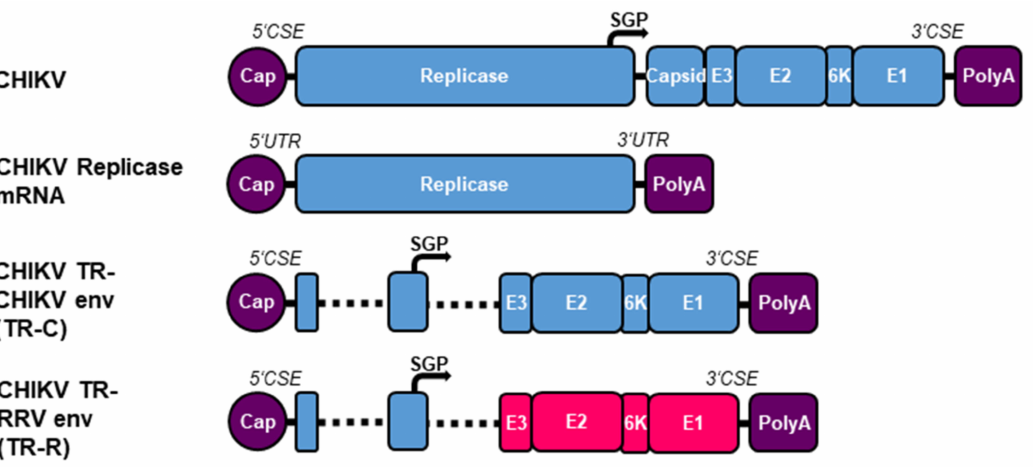
Figure 1. Schematic representation of the RNA constructs. The CHIKV replicase is encoded on a non-replicating mRNA with optimized 5 (cid:48) UTR and 3 (cid:48) UTR [31]. The CHIKV and RRV envelope proteins are encoded on TR-RNAs under the control of the CHIKV SGP (TR-C and TR-R). Both TR-RNAs contain the CHIKV CSEs, the first 231 nt of nsP1, and the last 1818 nt of nsP4. CHIKV sequences are indicated in blue and RRV in